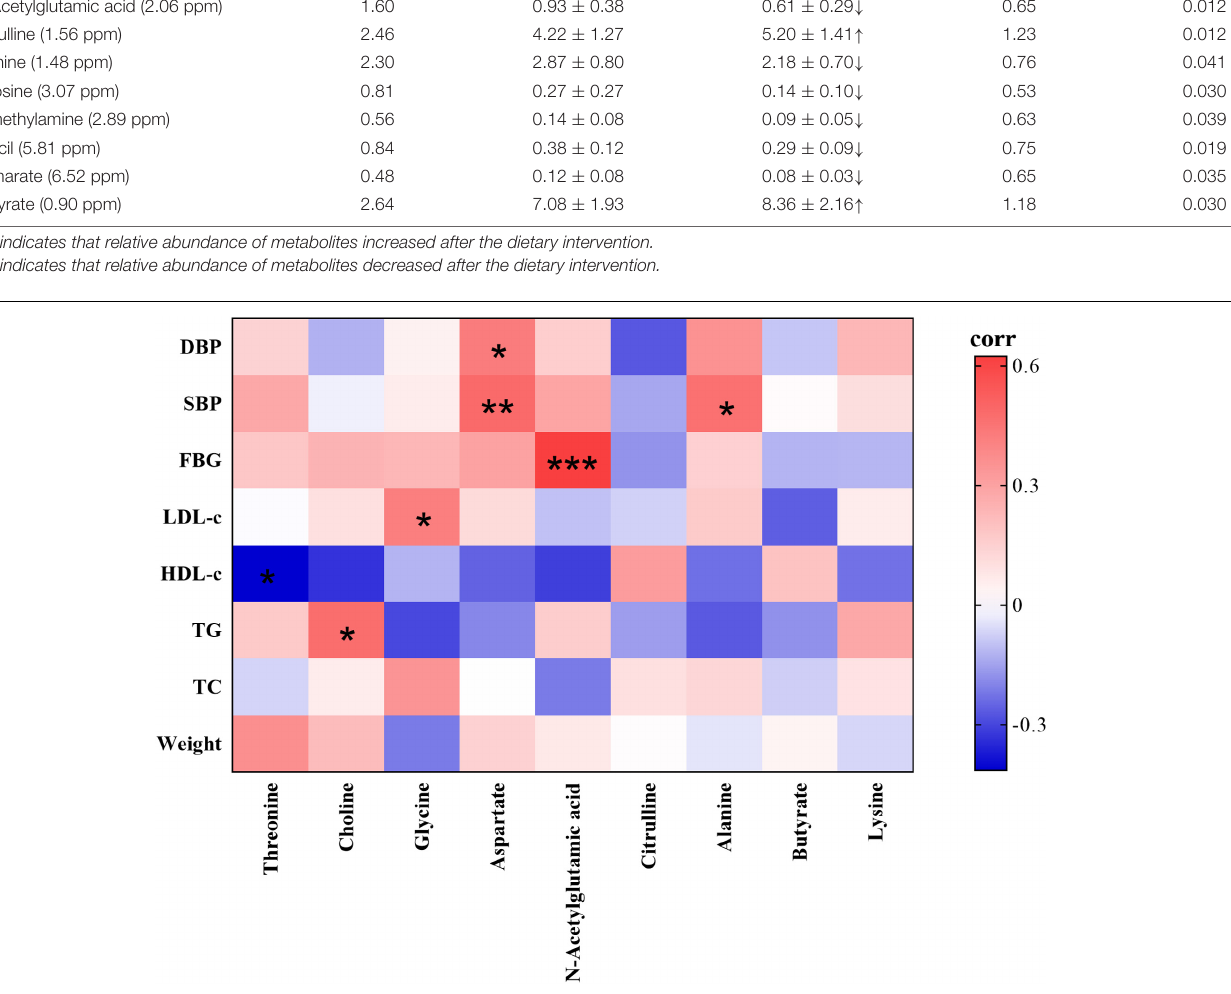
FIGURE 5 | Heatmap of correlations between the nine significantly different fecal metabolites identified and clinical parameters (red indicates a positive correlation, green indicates a negative correlation). Significantly correlated at * p < 0.05, ** p < 0.01, *** p < 0.001 (two-sided